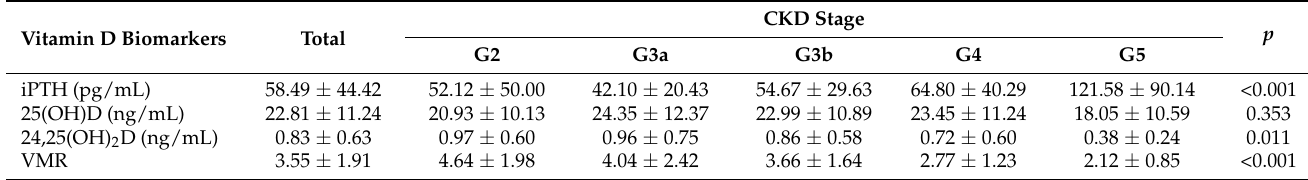
Table 2. iPTH and vitamin D biomarkers according to CKD stage.